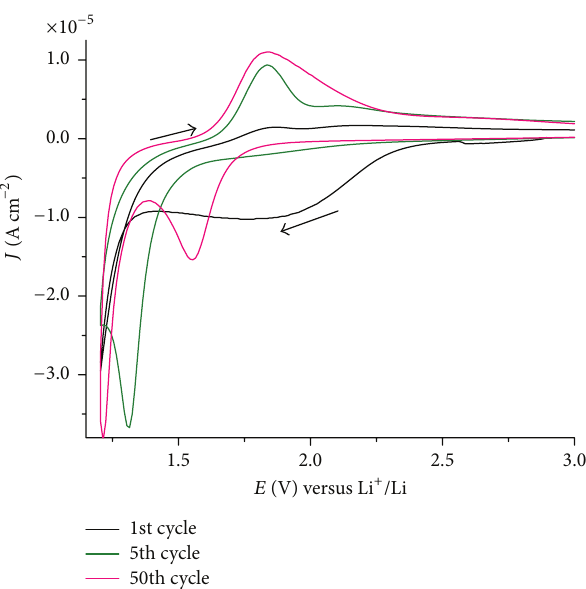
Figure 1: Evolution of the cyclic voltammogram of uncoated ITO. Electrolyte: 0.7 M LiClO 4 in anhydrous propylene carbonate; counter electrode: Li; reference redox couple: Li + /Li; scan rate: 5 mV s −1